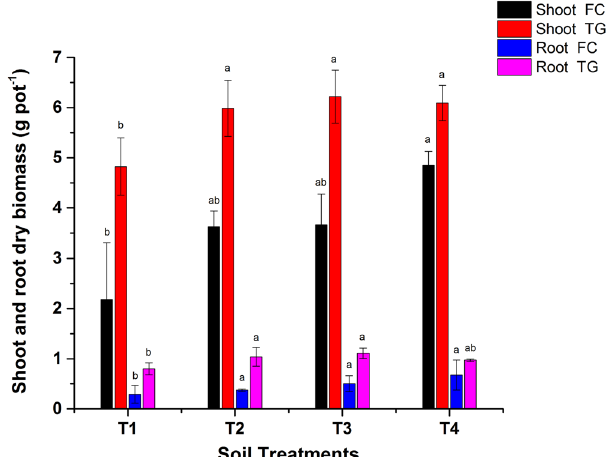
Figure 5. Effect of bamboo biochar on shoot and root dry biomass (g pot − 1 ) of Brassica juncea . The data represent the mean of three replicates, and the error bars are standard deviations. Means with different letters are significantly different ( p < 0.05). (T1 = Control, T2 = 1.0% BB, T3 = 2.5% BB, T4 = 5.0% BB).